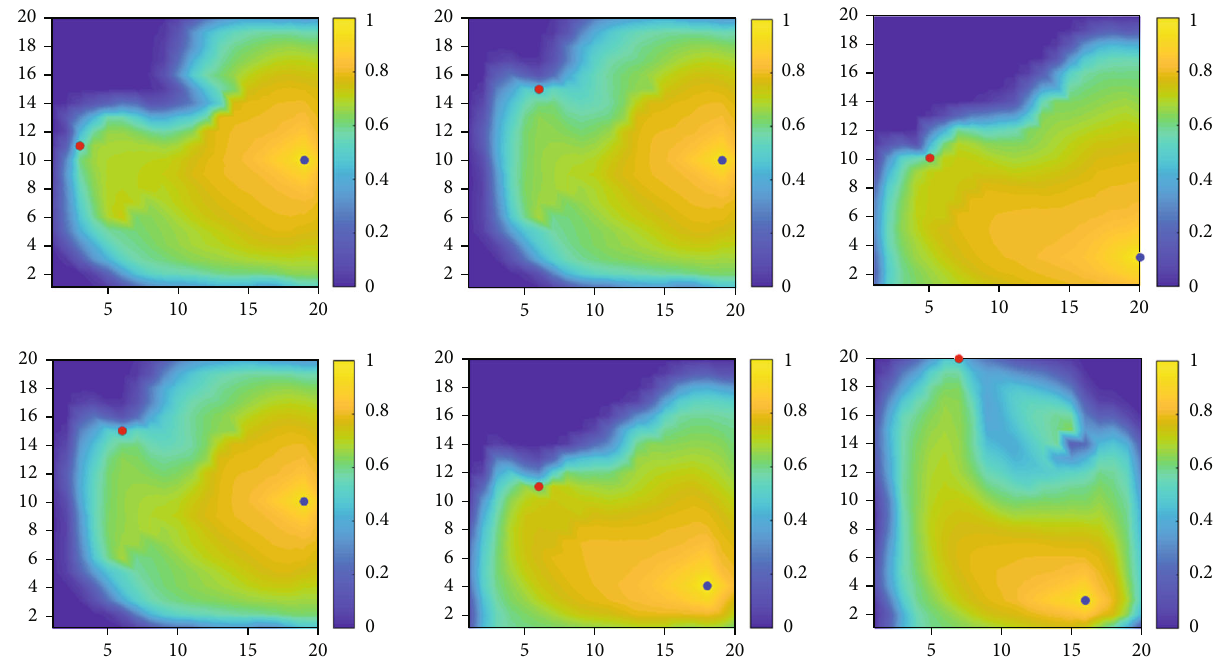
Figure 7: The optimal well locations plotted on the water saturation fi eld.